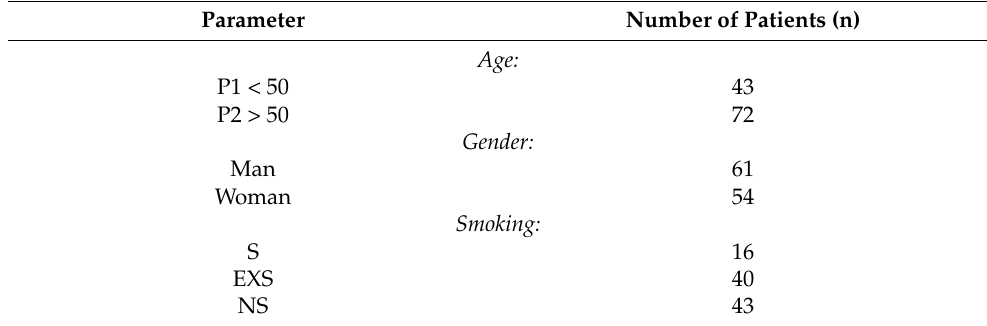
Table 1. Characteristic of the study population (P1—patients under 50 years old; P2—patients over 50 years old; S—current smokers, EXS—ex-smokers, NS—never-smoking patients; IDs— immunosuppressive drugs; AM—arithmetic mean; SD- standard deviation; GFR—glomerular filtra- tion rate; ALT—alanine transaminase;